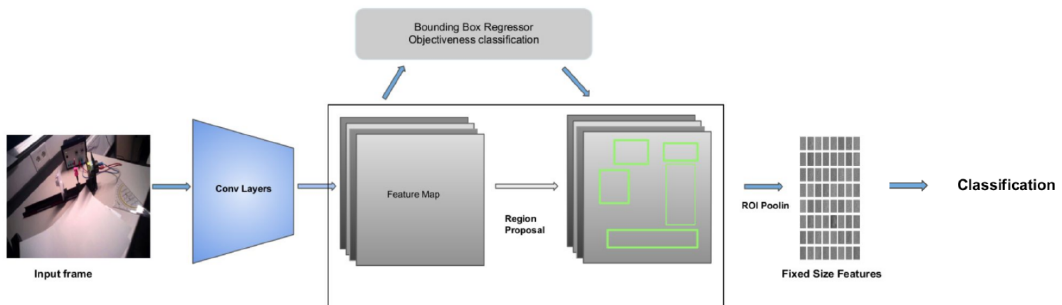
Figure 5. Architecture of Faster R-CNN. Figure adapted from